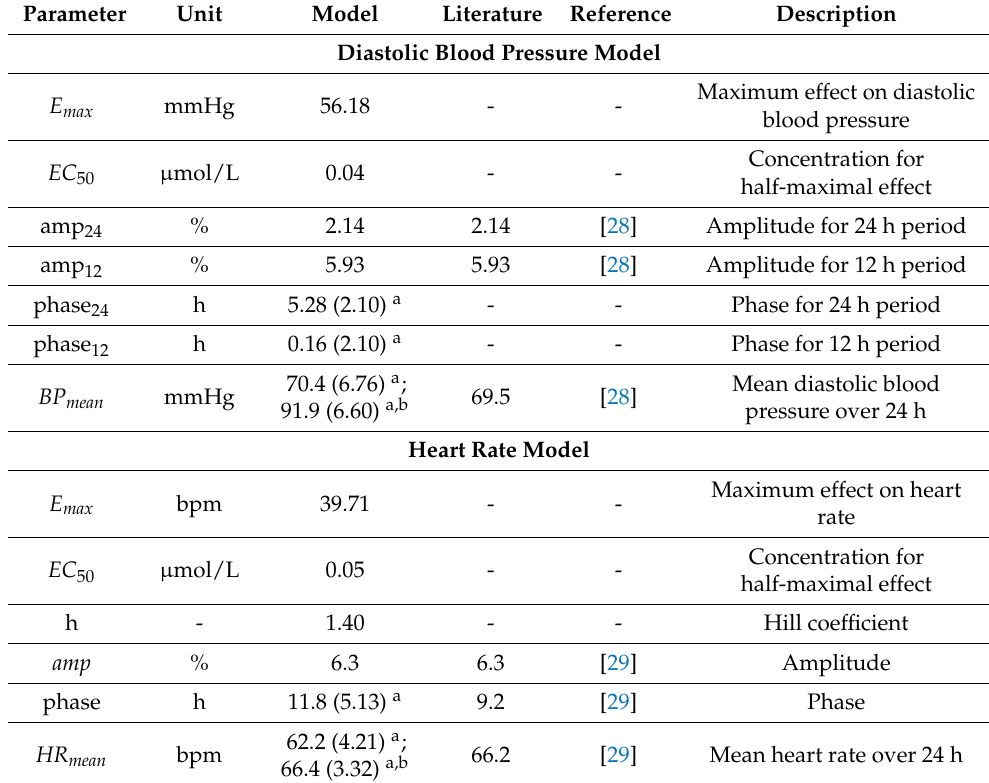
Table 3. Parameters used for the diastolic blood pressure and heart rate PD model. Parameter Unit Model Literature Reference